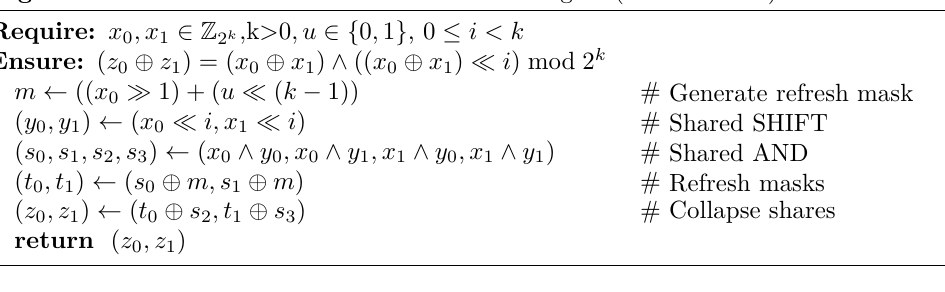
Algorithm 5 2-Share TI of a k -radix AND-SHIFT gate ( SecAndShift ).